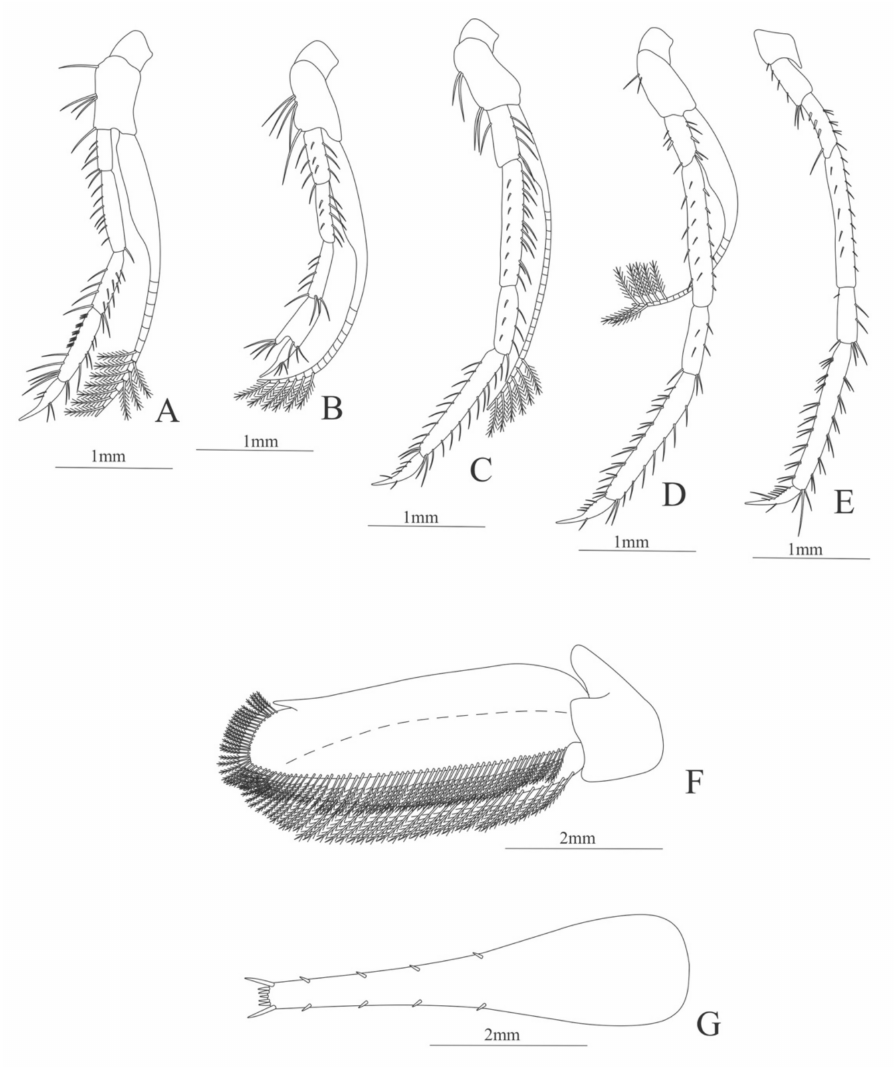
Figure 20. Heterocarpus ensifer : ( A ) first pereopod; ( B ) second pereopod; ( C ) third pereopod; ( D ) fourth pereopod; ( E ) fifth pereopod; ( F ) uropods; ( G ) telson. Plesionika Spence Bate, 1888 Plesionika edwardsii (J.F. Brandt in von Middendorf,